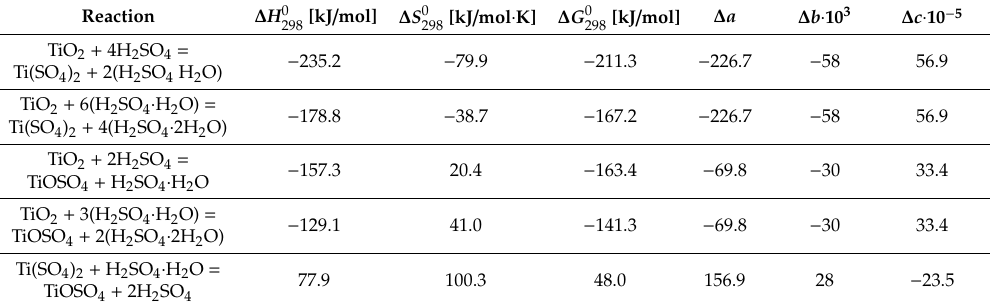
Table 1. Thermodynamic data for chemical transformations in the TiO 2 –SO 3 –H 2 O system.